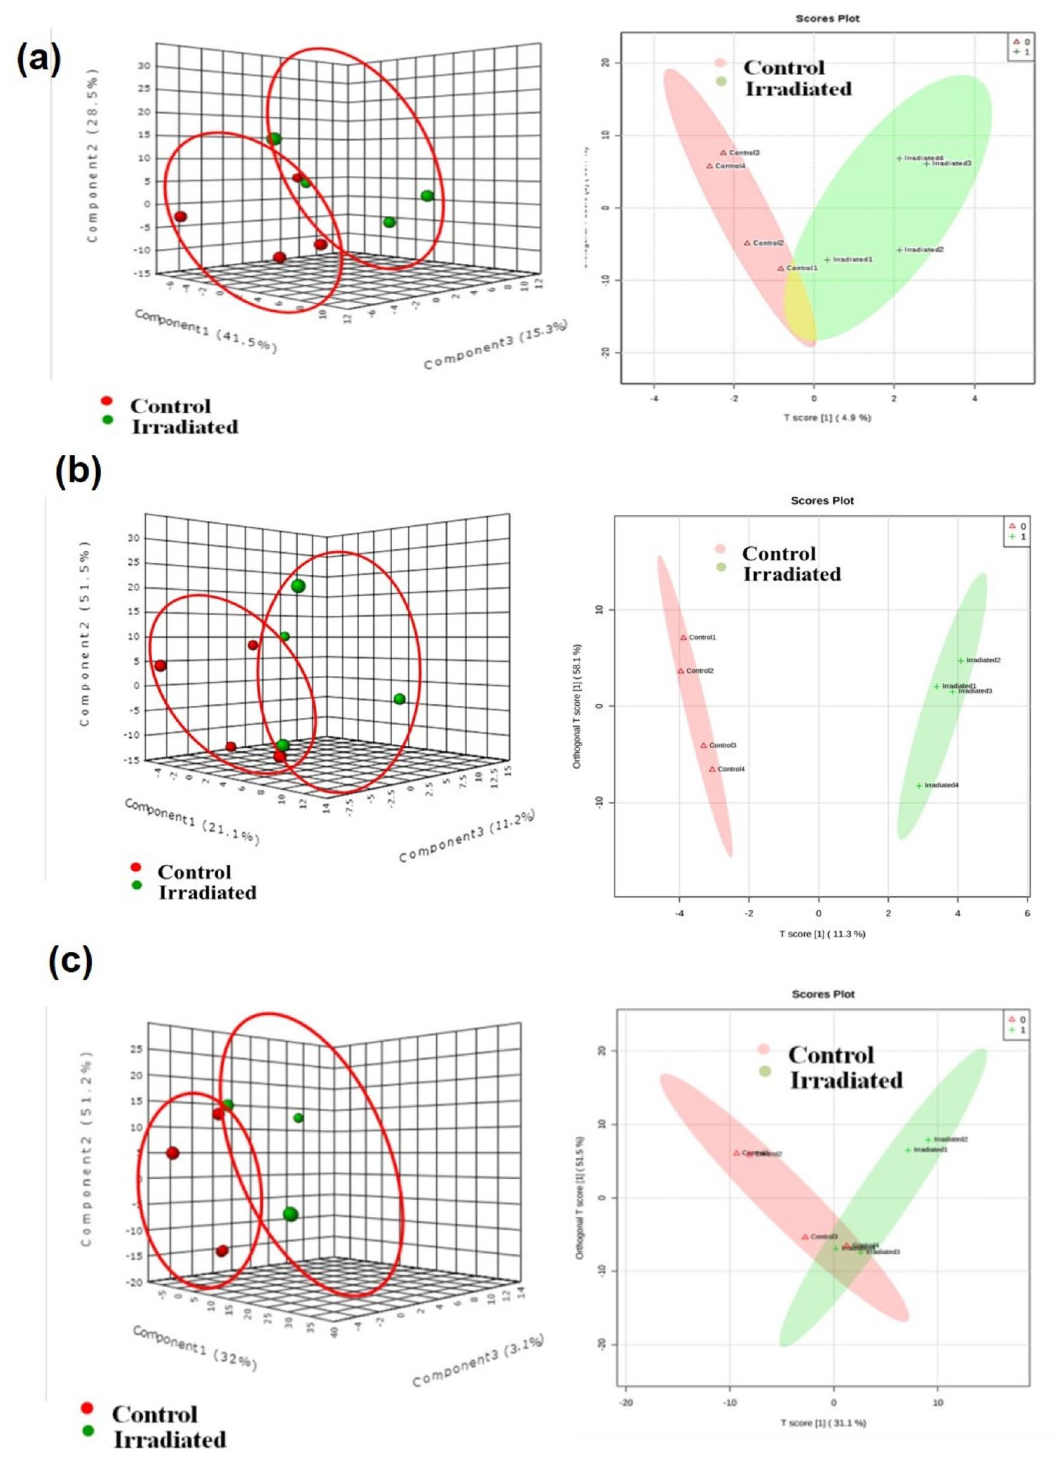
Figure 4. Multivariate analysis score plots of metabolites of seedlings Principal component analysis (PCA) and Orthogonal partial least squares discriminant analysis (OPLS-DA) score plot of control and laser-irradiated group at ( a ) 14 DAI ( b ) 21 DAI and ( c ) 28 DAI. Data were obtained from positive and negative ESI ionization mode (n =